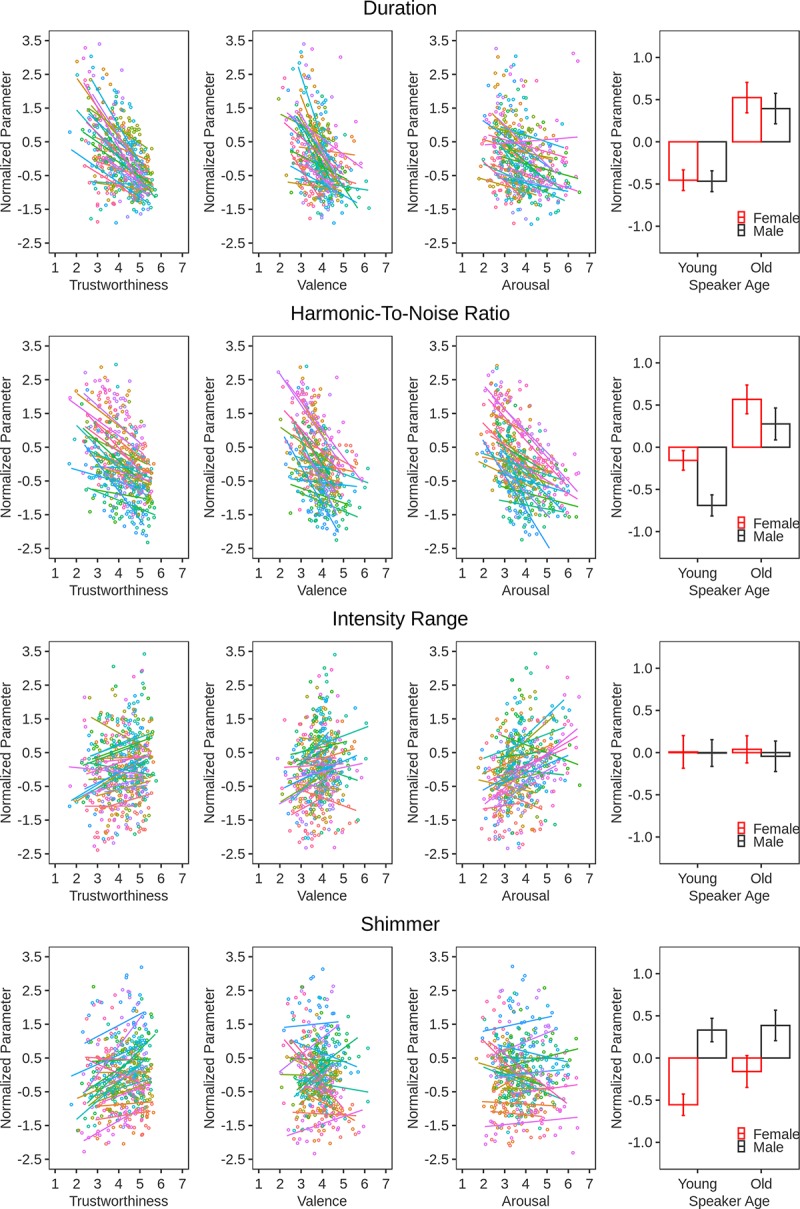
Illustration of the relationship between acoustic measures (i.e., utterance duration, HNR, intensity range, and shimmer) and other stimulus properties.Normalized vocal parameters (y-axes) are plotted as a function of trustworthiness ratings, valence, arousal, and speaker characteristics (x-axes). The individual points in the scatter plots represent the 13 expressions for the 2 sentences produced by each speaker. These points are summarized by a regression line for each speaker. The error bars in the bar-graphs represent the 95% confidence intervals.